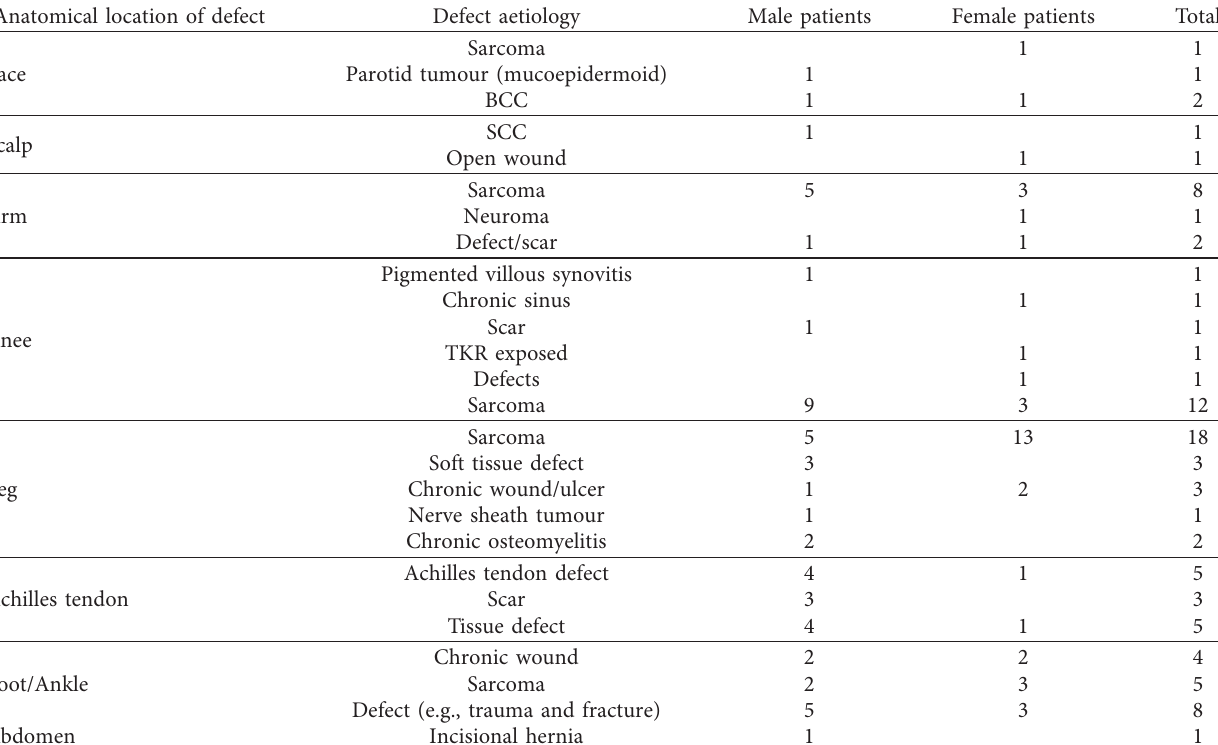
Table 1: Aetiologies of soft tissue defects requiring ALT flap